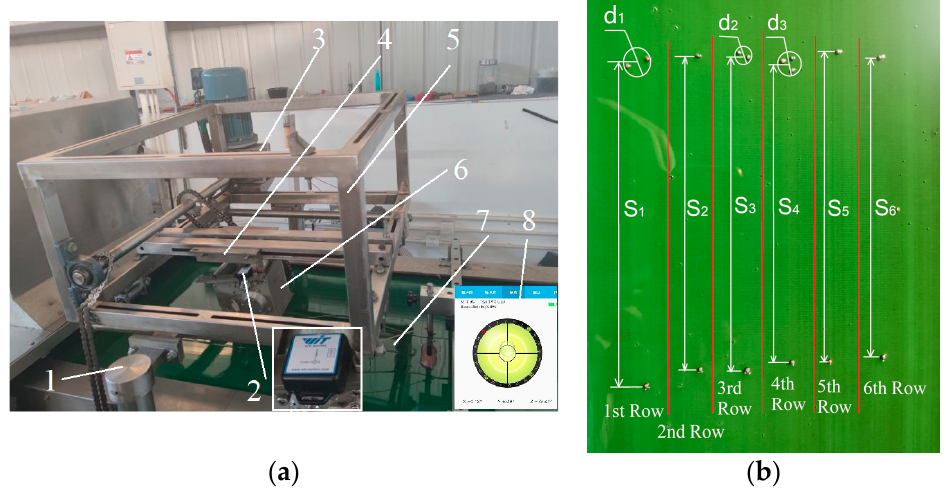
Figure 5. Bench test platform ( a ) and seed ridge-spacing measurement method ( b ). Note: (1) height adjusting mechanism, (2) inclination MEMS sensor, (3) gear motor, (4) inclination adjusting mechanism, (5) JPS-12 seed meter performance test bench, (6) centralized seed-metering device, (7) oiled belt, (8) inclination monitor.